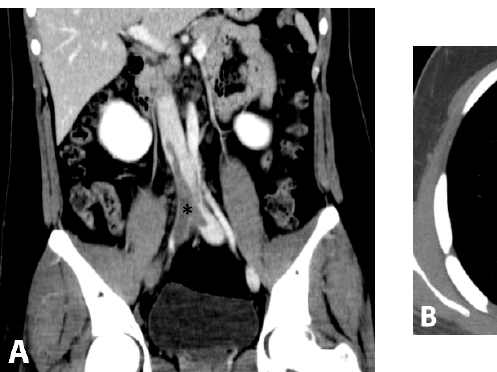
Figure 1. ( A ) . Computed tomography showed partial thrombosis of the inferior vena cava and total occlusion of right iliac veins (asterisk). ( B ). Axial computed tomography pulmonary angiography image showed pulmonary embolism at the right descending pulmonary artery (arrow). ( C ). Kidney biopsy finding, light microscopy of glomerulus with Jone silver stain (original magnification, ×200) revealed normal glomerulus.